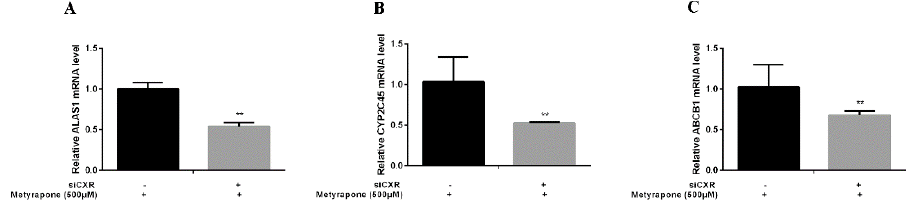
Figure 5. RT-PCR analysis of ALAS1 ( A ), CYP2C45 ( B ) and ABCB1( C ) mRNA levels in chicken primary hepatocytes treated with 500 µ M metyrapone after siRNA-mediated knockdown of CXR. Bars show means ± SD of three independent experiments. ** p < 0.01, compared with the control group.